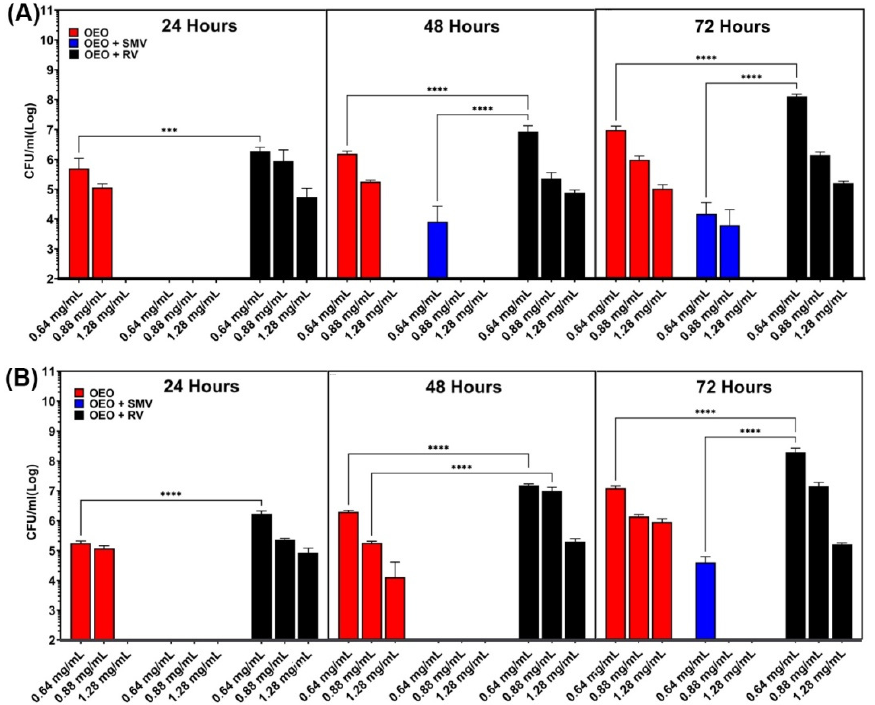
Figure 8. In vitro long-term bacterial inhibition efficacy of OEO loaded SMV, OEO-loaded RV and free OEO towards ( A ) E. coli ( B ) S. epidermidis (statistical significance calculated by the multiple comparison test, *** p = 0.0003, **** p < 0.0001). In order to investigate the contribution of the particle size of the OEO carrier, the long-term antibacterial efficacy of the loaded RV (size 1–5 mm) was also evaluated using the same method. At all three OEO concentrations, OEO-loaded RV showed more viable E. coli colonies than free OEO or OEO-loaded SMV (Figure 8A), indicating the lowest bactericidal activity. At the lowest OEO concentration of 0.64 mg/mL, the CFU/mL values of the OEO-loaded RV were 1.9 × 10 6 , 8.2 × 10 6 and 1.2 × 10 8 at 24, 48 and 72 h, respec- tively. At the OEO concentration of 0.88 mg/mL, the CFU/mL values of OEO-loaded RV were 8.7 × 10 5 , 2.1 × 10 5 and 1.3 × 10 6 at 24, 48 and 72 h, respectively. At the OEO concen- tration of 1.28 mg/mL, the CFU/mL values of OEO-loaded RV were 5.6 × 10 4 , 7.5 × 10 4 and 1.5 × 10 5 at 24, 48 and 72 h, respectively. The statistical analysis indicated a statistically significant difference among the 0.64 mg/mL groups ( p = 0.0003 at 24 h and p < 0.0001 at 48 and 72 h). The in vitro antibacterial test was also carried out using the Gram-positive model, which showed a similar trend to the Gram-negative model (Figure 8B). At the lowest OEO concentrations of 0.64 mg/mL (CFU/mL 1.8 × 10 5 , 1.9 × 10 6 and 1.2 × 10 7 at 24, 48 and